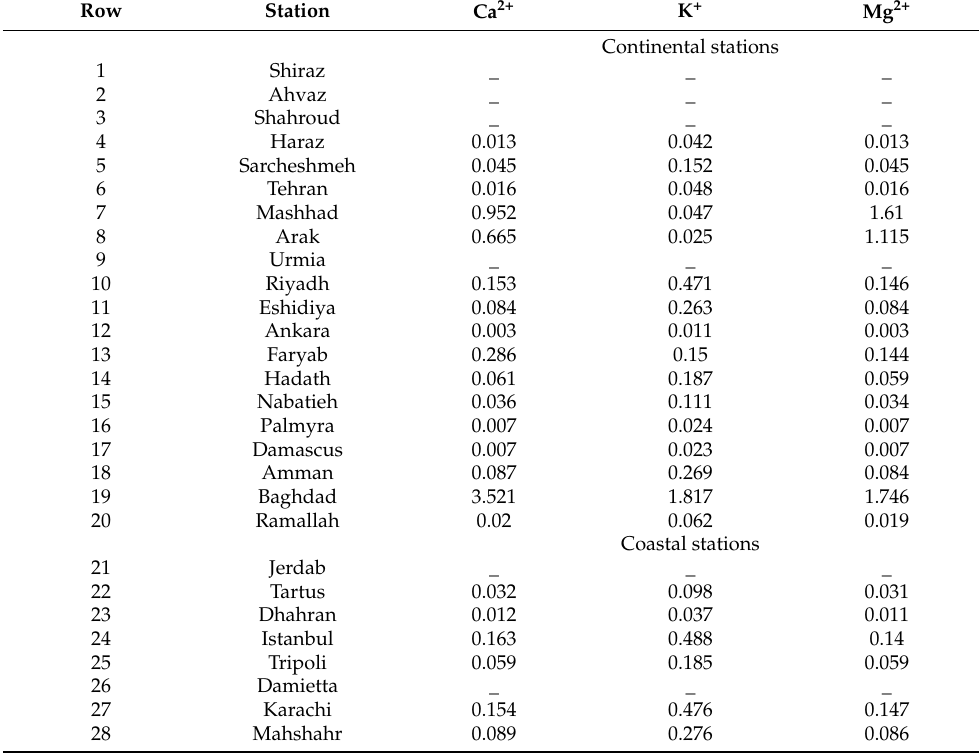
Table 3. The NFs of the major ions in the Middle East